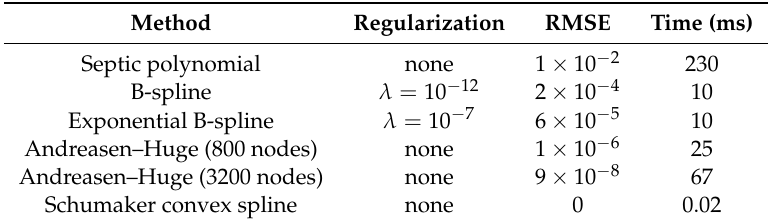
Table 3. Root mean square error (RMSE) of the collocation method implied volatilities against the implied volatilities of Table A2 in Appendix